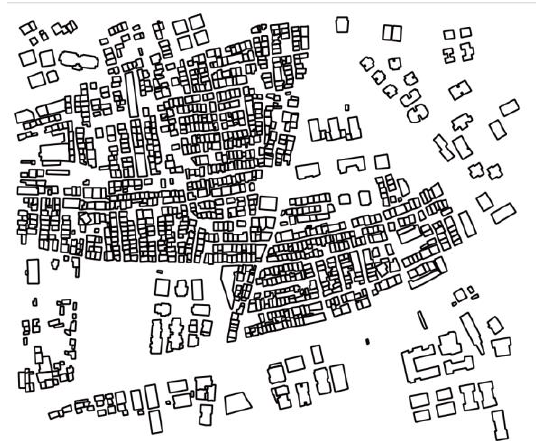
Figure 5. Building footprint vectors.